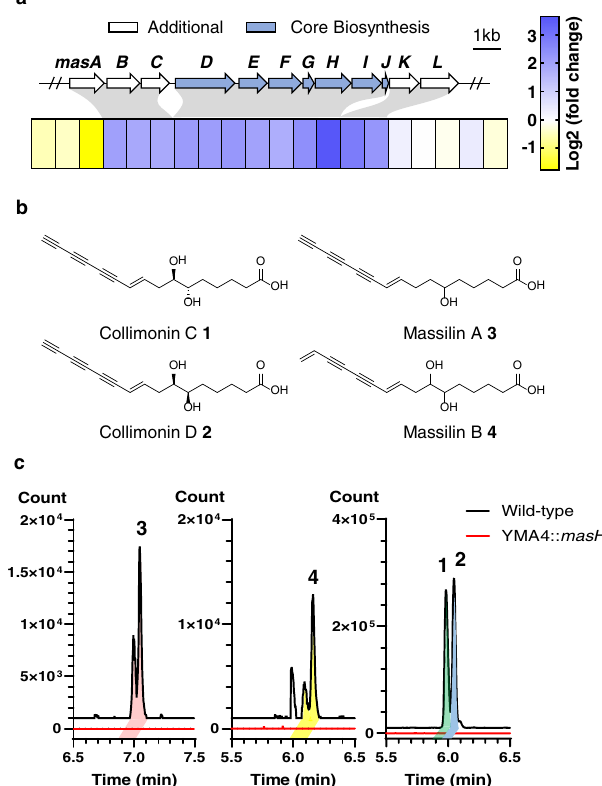
Fig. 1 Polyynes and polyyne biosynthesis gene cluster of Massilia sp. YMA4. a Gene expression pro fi le around the mas BGC under polyyne production (PDA) versus non-production (YMA) medium. The expressions of additional and core biosynthesis genes of mas BGC are framed in the gray area. b Structure of polyynes collimonin C/D 1 , 2 and massilin A/B 3 , 4 . c Extraction ion chromatography (EIC) of collimonin C/D 1 , 2 ( m/z 273.1132), massilin A 3 ( m/z 257.1183), and massilin B 4 ( m/z 275.1289) in Massilia sp. YMA4 wild type (black) and the biosynthesis null mutant strains (YMA4:: masH ) with a 10 ppm mass